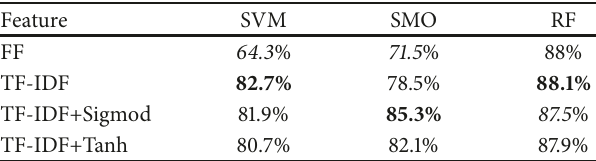
Table 10: Recognition results using LSTM concerning dataset